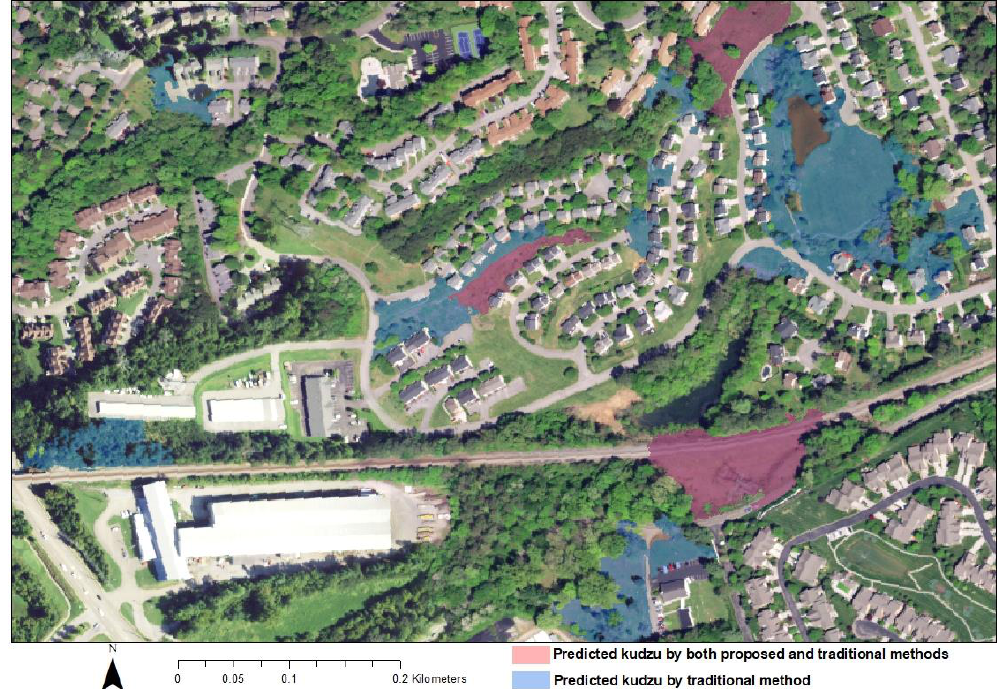
Figure 5. A scene of detected kudzu by the best support vector machine (SVM) model using the proposed method and by the traditional method with one-step sampling using SVM. Both models detected all three kudzu patches in this landscape (shown in red), whereas the traditional method misclassified more herbaceous vegetation into kudzu (shown in blue). The image taken in April (from NAIP 2016) was used as the background image.